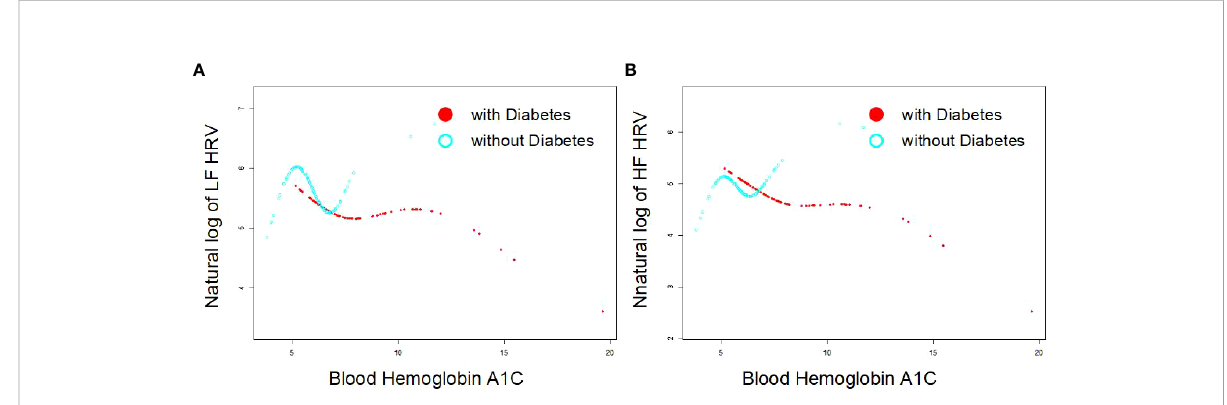
FIGURE 1 Single exponential smooth curve for the associationbetween bloodHbA1c and HRV [As (A, B) indicates, the single-factor smooth curve shows inverse relationships between bloodHbA1c levels and HF-HRV and LF-HRV values in participants with DM (P<0.05)but notin those without DM